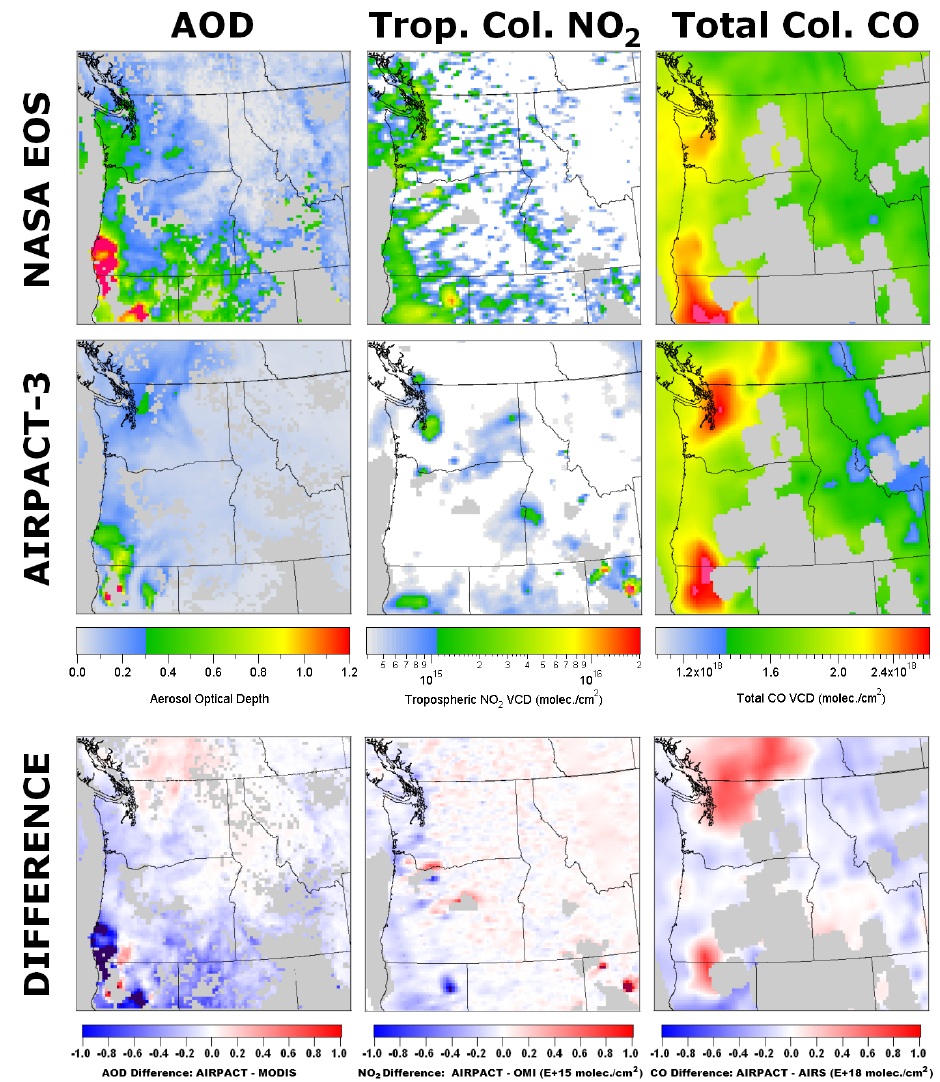
Figure 5. AOD (left column), tropospheric NO 2 columns (middle column), and total carbon monoxide columns (right column) for 29 June 2008 ( ∼ 2p.m.LST) with NASA EOS retrieval (top row), AIRPACT-3 with SMOKE plume rise (middle row), and differences (bottom row). Gray color indicates no or low-quality data from the satellite retrieval and exclusion from analysis. Values greater than the color scale maximum are shown as pink in the AIRPACT-3 and NASA EOS maps. Values outside the range of the difference color scales are shown as saturated